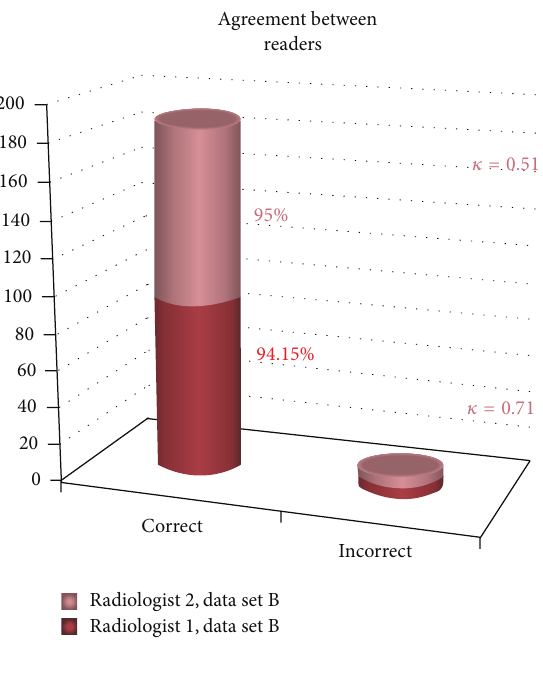
Figure 4: Agreement between